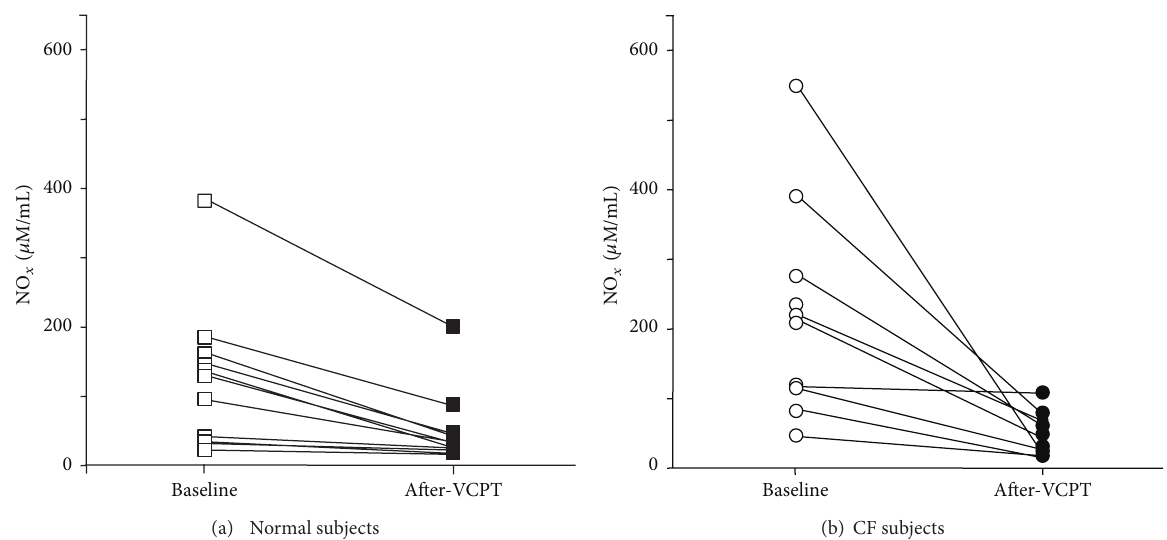
Figure 4: Exhaled breath condensate (EBC) oxides of nitrogen ( 𝑁𝑂 𝑥 ) following VCBT. (a) All 11 normal subjects sustained a decrease in EBC NO 𝑥 concentrations. (b) All nine cystic fibrosis subjects also sustained a decrease in EBC NO 𝑥 concentrations.